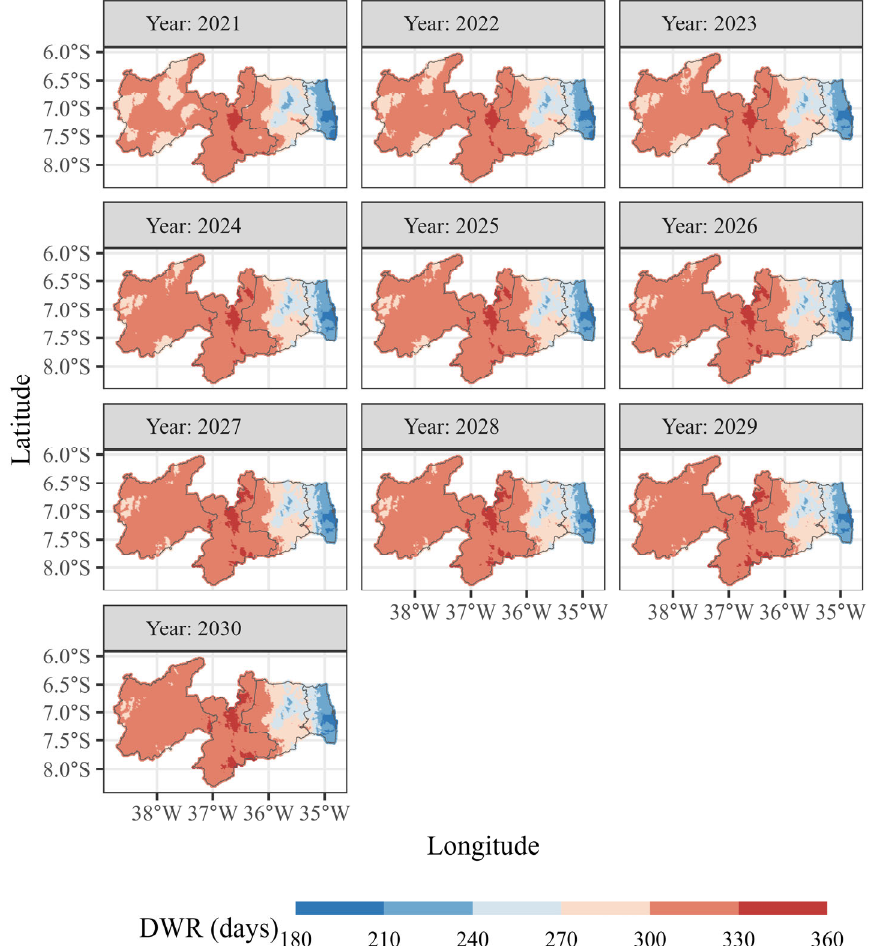
Figure 7. Spatiotemporal kriging for the annual number of days without rain (DWR) in the State of Paraíba.